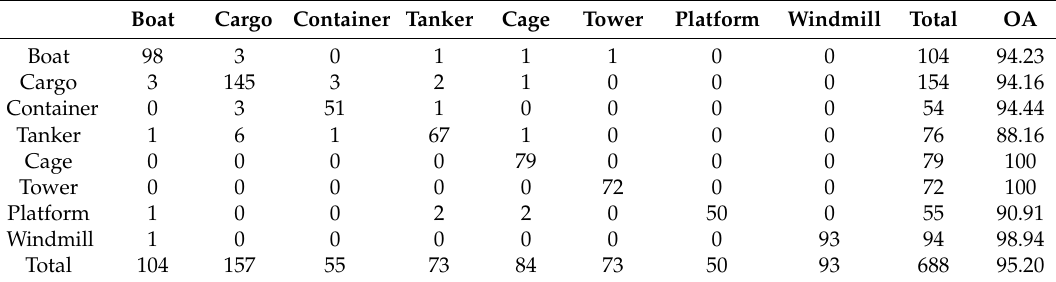
Table 4. Confusion matrix of 8-class classification results of MT-CNN.